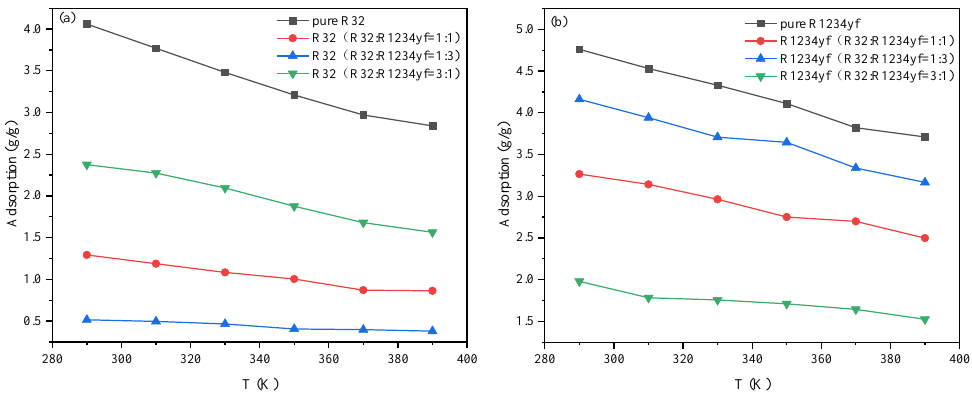
Figure 2. Adsorption capacity of R32 and R1234yf in MOF-200 at different temperatures. ( a ) R32; ( b ) R1234yf. Table 3. Adsorption capacity of R32 and R1234yf in MOF-200 and Zn-MOF-74. MOF-200